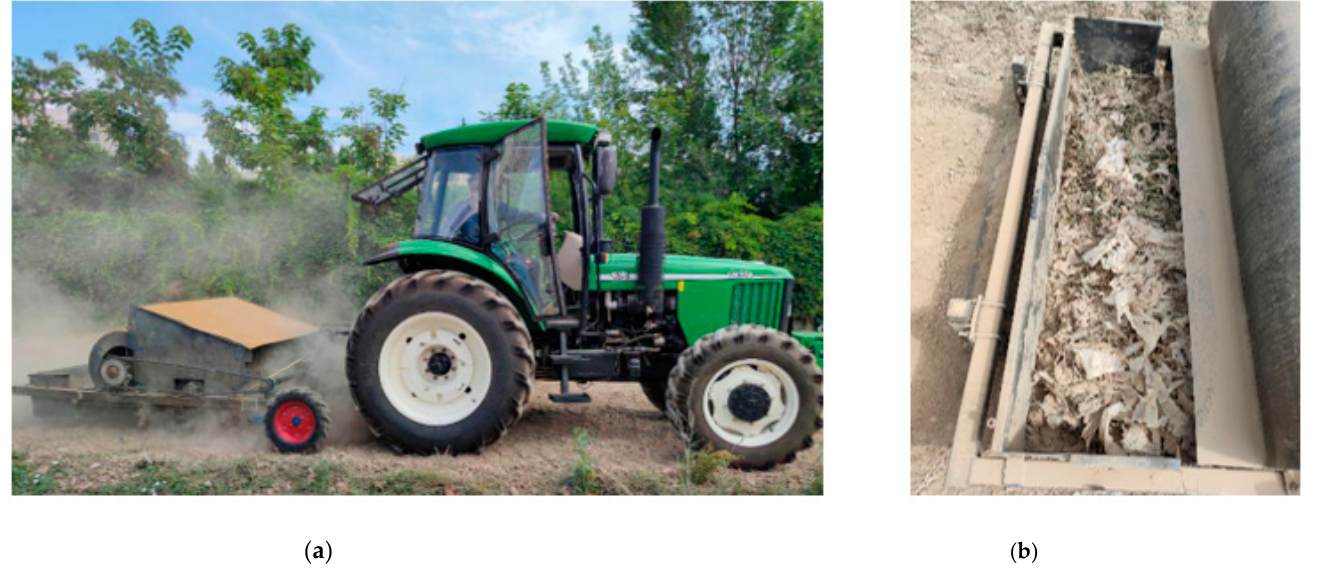
Figure 17. Field test ( a ) and removal and recovery effect of residual film ( b ). Table 6. Test results.